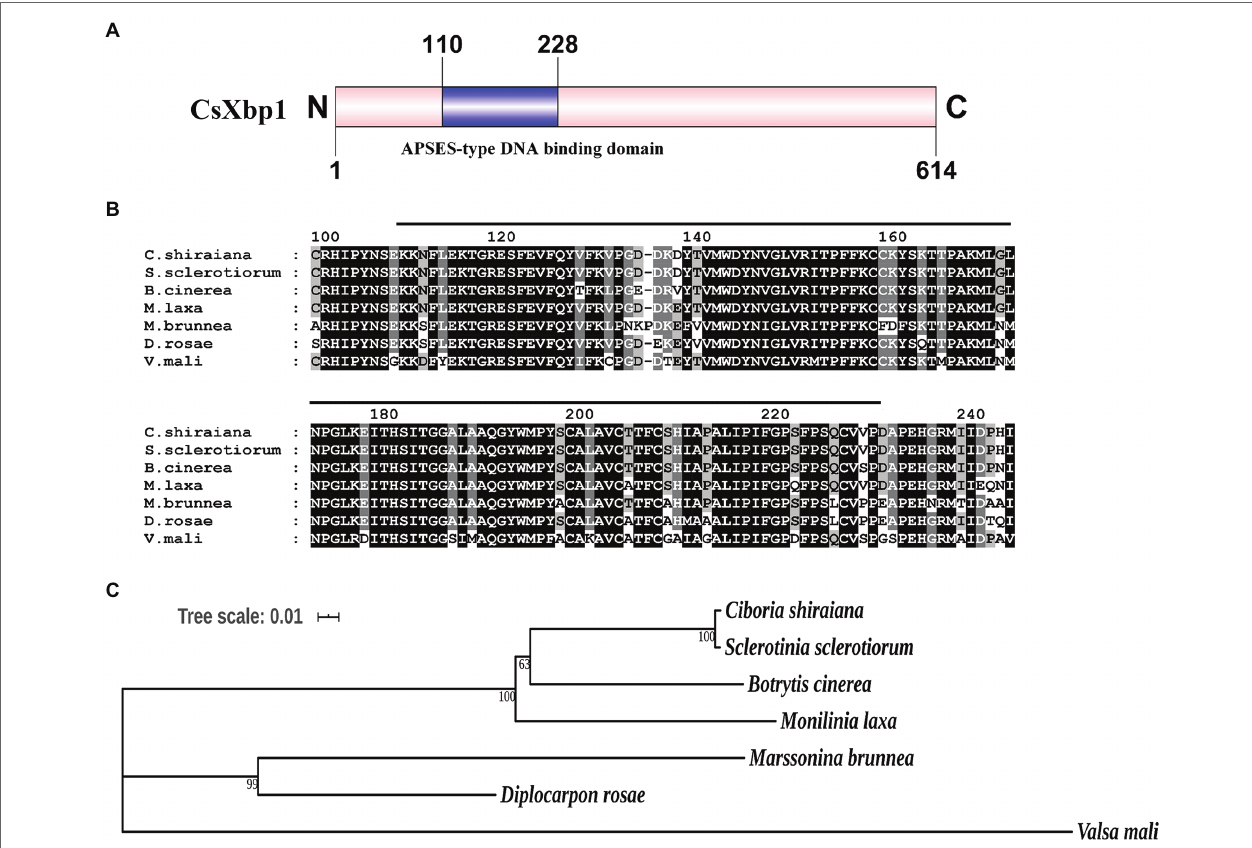
FIGURE 1 | Sequence alignment and phylogenetic analysis of CsXbp1. (A) The predicted functional domain of CsXbp1. The full length of CsXbp1 is framed by a pink box and the APSES-type DNA binding domain is framed by a blue box. Numbers indicate the amino acid of the predicted protein. (B) Multiple sequence alignment of APSES-type DNA binding domain among CsXbp1 and its homologous proteins. Shading indicates sequence similarities of 100% (dark). Numbers indicate the amino acid of the predicted polypeptide. The black line indicates the APSES-type DNA binding domain region of the proteins. (C) Phylogenetic relationships among APSES-type DNA binding proteins. The phylogenetic tree was generated using neighbor-joining method, and bootstrap support values of 1,000 replicates are given above the branches. The scale bar corresponds to 0.01 estimated amino acid substitutions per